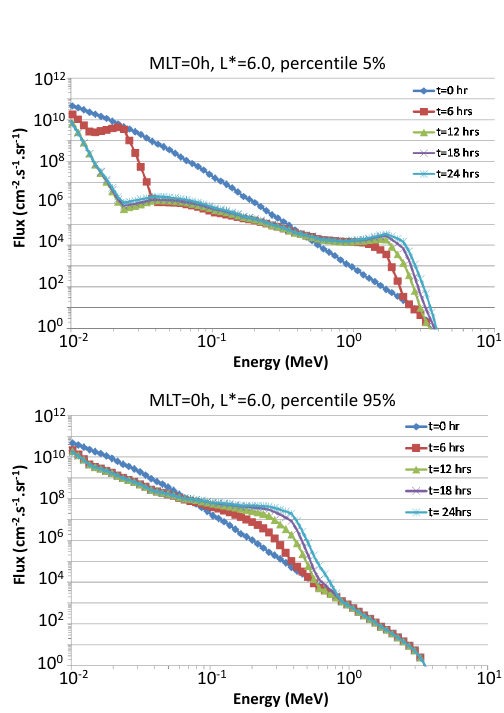
Figure 7. Time evolution of electron flux due to chorus waves at Fig. 7 Time evolution of electron flux due to chorus waves at MLT=0h for L*=6.0 using 707 MLT = 0h for L ∗ = 6.0 using extreme electron plasma density val- extreme electron plasma density values :percentile 5% on top (low density) and percentile 708 ues:percentile 5% on top (low density) and percentile 95% on bot- tom (high density). The flux is shown at interval of 95% on bottom (high density). The flux is shown at interval of 6 hours. 709